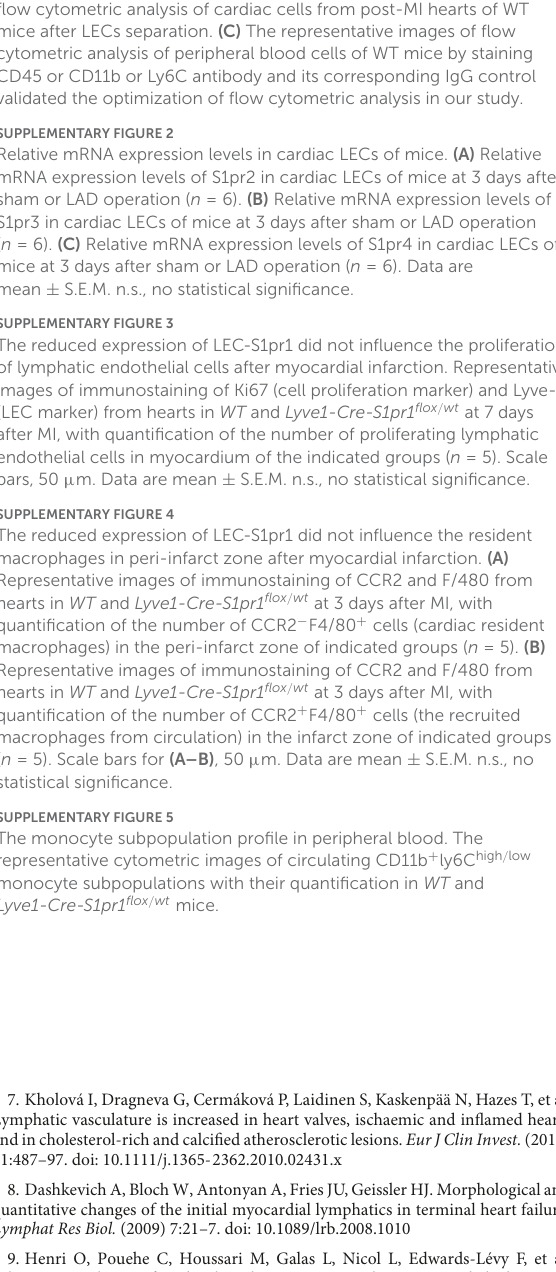
images of flow cytometric analysis of cardiac cells from post-MI hearts of WT mice before LECs separation. (B) The representative images of flow cytometric analysis of cardiac cells from post-MI hearts of WT mice after LECs separation. (C) The representative images of flow cytometric analysis of peripheral blood cells of WT mice by staining CD45 or CD11b or Ly6C antibody and its corresponding IgG control validated the optimization of flow cytometric analysis in our study. SUPPLEMENTARYFIGURE2 Relative mRNA expression levels in cardiac LECs of mice. (A) Relative mRNA expression levels of S1pr2 in cardiac LECs of mice at 3 days after sham or LAD operation ( n = 6). (B) Relative mRNA expression levels of S1pr3 in cardiac LECs of mice at 3 days after sham or LAD operation ( n = 6). (C) Relative mRNA expression levels of S1pr4 in cardiac LECs of mice at 3 days after sham or LAD operation ( n = 6). Data are mean ± S.E.M. n.s., no statistical significance. SUPPLEMENTARYFIGURE3 The reduced expression of LEC-S1pr1 did not influence the proliferation of lymphatic endothelial cells after myocardial infarction. Representative images of immunostaining of Ki67 (cell proliferation marker) and Lyve-1 (LEC marker) from hearts in WT and Lyve1-Cre-S1pr1 flox / wt at 7 days after MI, with quantification of the number of proliferating lymphatic endothelial cells in myocardium of the indicated groups ( n = 5). Scale bars, 50 µ m. Data are mean ± S.E.M. n.s., no statistical significance. SUPPLEMENTARYFIGURE4 The reduced expression of LEC-S1pr1 did not influence the resident macrophages in peri-infarct zone after myocardial infarction. (A) Representative images of immunostaining of CCR2 and F/480 from hearts in WT and Lyve1-Cre-S1pr1 flox / wt at 3 days after MI, with quantification of the number of CCR2 − F4/80 + cells (cardiac resident macrophages) in the peri-infarct zone of indicated groups ( n = 5). (B) Representative images of immunostaining of CCR2 and F/480 from hearts in WT and Lyve1-Cre-S1pr1 flox / wt at 3 days after MI, with quantification of the number of CCR2 + F4/80 + cells (the recruited macrophages from circulation) in the infarct zone of indicated groups ( n = 5). Scale bars for (A–B) , 50 µ m. Data are mean ± S.E.M. n.s., no statistical significance. SUPPLEMENTARYFIGURE5 The monocyte subpopulation profile in peripheral blood. The representative cytometric images of circulating CD11b + ly6C high / low monocyte subpopulations with their quantification in WT and Lyve1-Cre-S1pr1 flox / wt